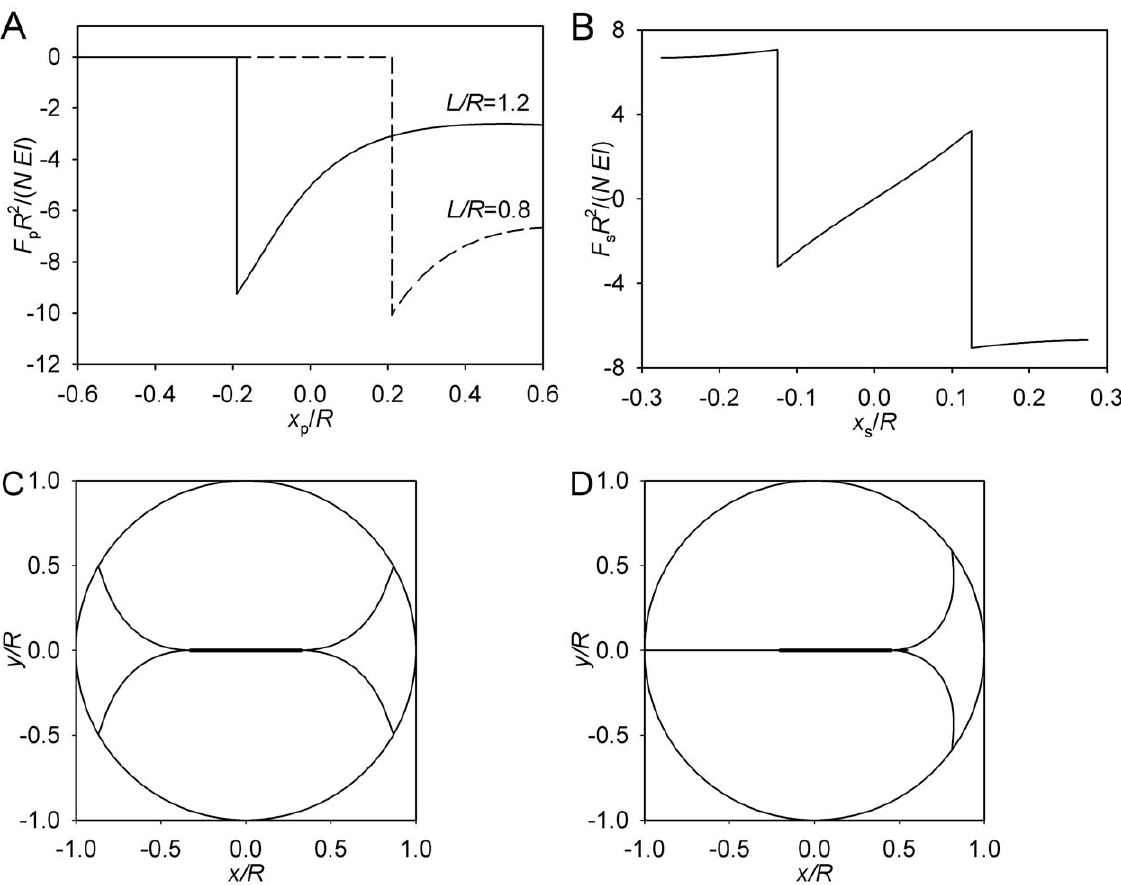
Figure 2. Limiting case of h max =0. (A) Pole force function. (B) Spindle force function. (C) Symmetric equilibrium. (D) Asymmetric equilibrium. B–D: L =0.8 R , S =0.65 R . For clarity, only two microtubule forms are plotted. These microtubules lie in the ( x , y ) plane that passes through the spindle axis. The circumference is the section of the cell surface, and the thicker line segment depicts the spindle proper.